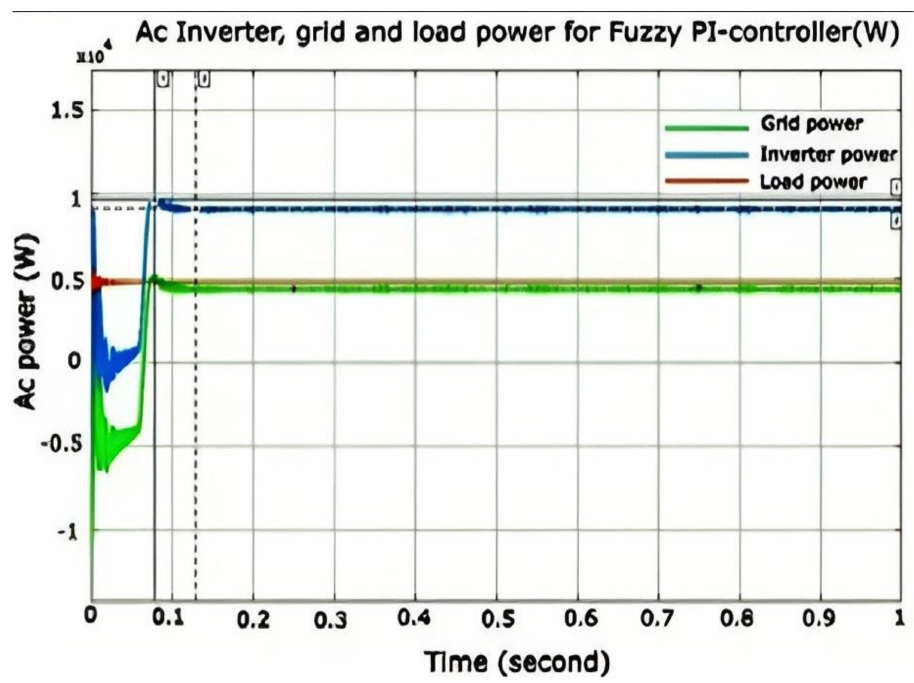
Figure 11. AC output (inverter, grid, and load) power supply for low-load fuzzy-PI controllers. 4. GUI for System Design and Sizing for All Components of the System Modules Matlab GUI is used for the sizing of a complete PV system (sizing of PV array, sizing of the boost converter and sizing of the inverter), shown in Figure 12.